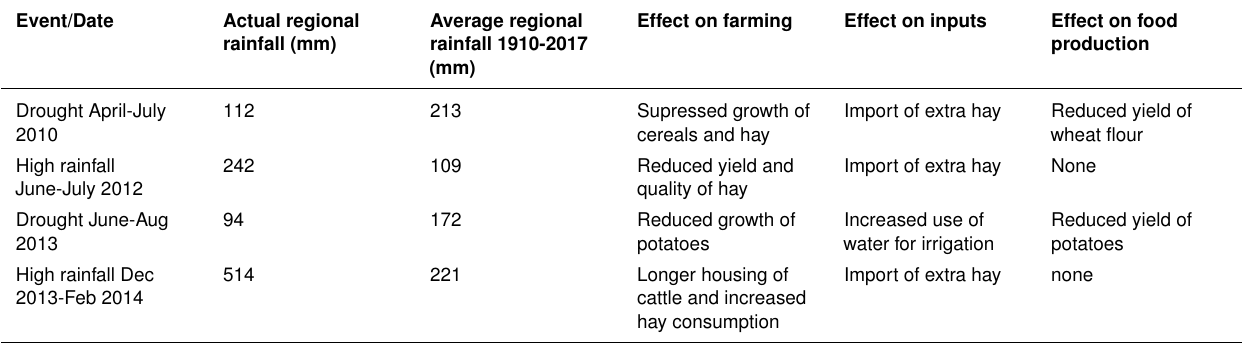
Table 8. Anomalous weather events and their effect on production, 2010–2017.